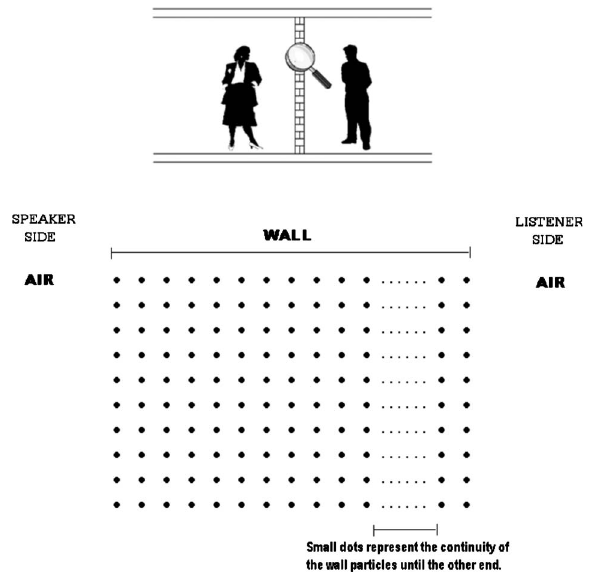
FIG. 8. Picture available to students for better understanding of the situation and for optional drawing during discussion related to context 4a in interview protocol.